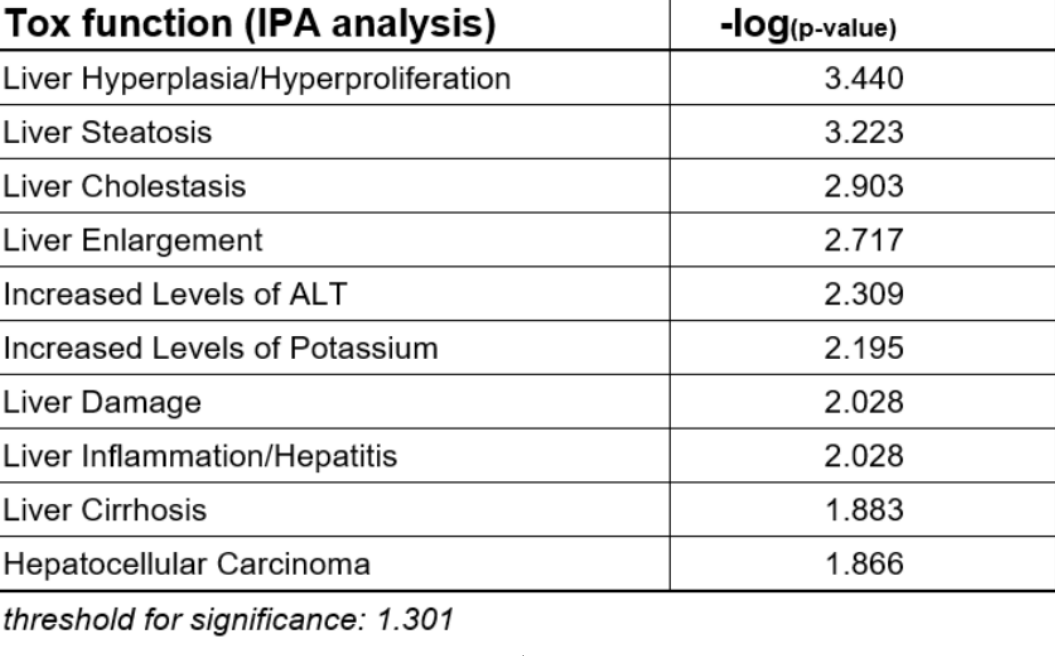
Figure 1. Adverse outcome pathway (AOP) for liver cholestasis and transcriptomic evidence for cholestatic effects of propiconazole (Pi) and tebuconazole (Te) in human liver cells. ( a ) Schematic representation of an AOP for liver cholestasis modified after a previous publication [2]. Inhibition of the bile salt export pump (BSEP) as the molecular initiating event (MIE; orange) triggers several key events (red) that in turn lead to the adverse outcome of liver cholestasis (grey). AO: Adverse outcome, BSEP: Bile salt export pump, FXR: farnesoid-X-receptor, CAR: constitutive androstane receptor, PXR: pregnane-X-receptor. ( b ) Bioinformatic analysis of transcriptome data indicates alterations in several hepatotoxicity-related pathways after treatment of HepaRG cells with a mixture of Pi and Te (10 μM each), including liver hyperplasia and hyperproliferation, liver steatosis, and in this specific case, liver cholestasis. The most prominently affected pathways (“Tox Functions”) are depicted, as identified using IPA (Ingenuity Pathway Analysis) software. Data analysis was performed using transcriptomics data from a previous study